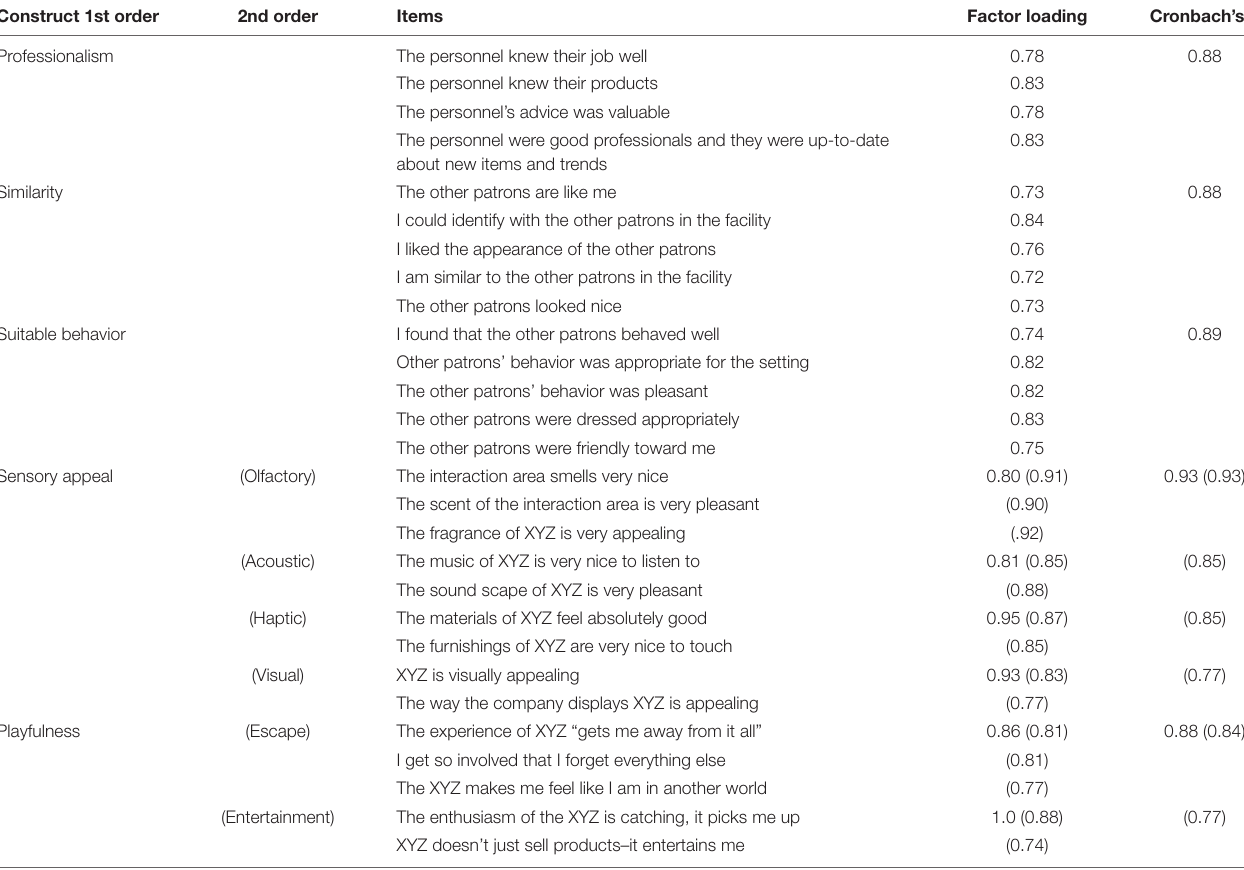
TABLE 5 | Confirmatory factor analysis (CFA) for experiential value in multi-actor service ecosystems. Construct 1st order